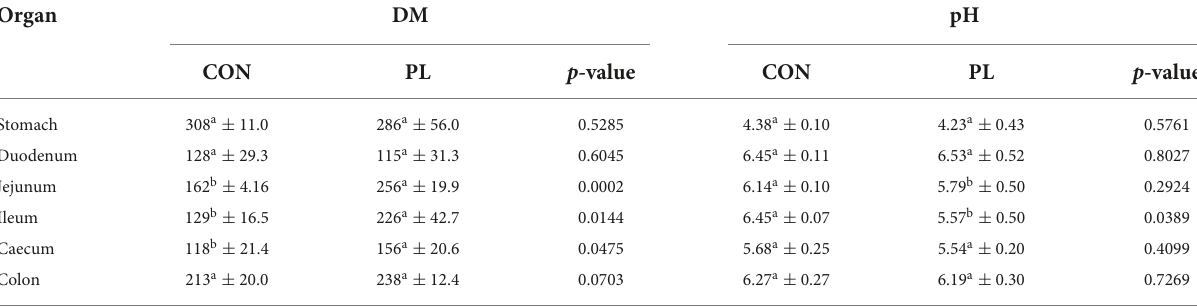
TABLE 8 Dry matter content (g/kg FM 1 ) and the pH values of the digesta in the individual sections of the GIT of the animals in both groups at the time of dissection (mean ±